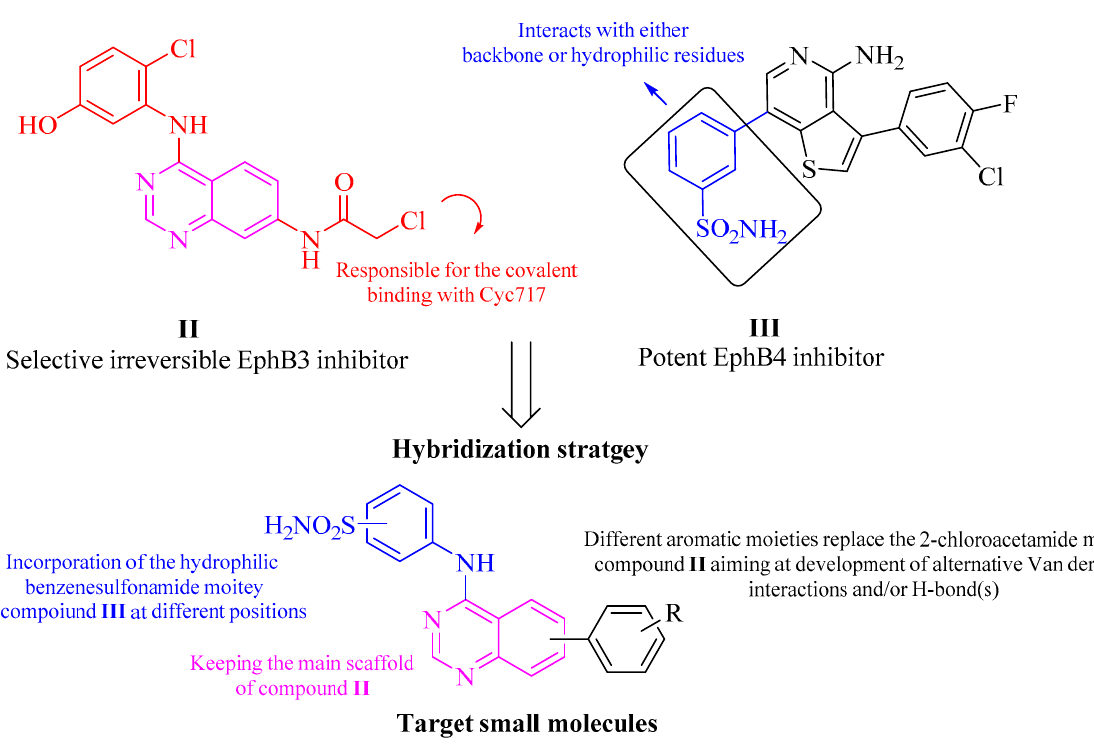
Figure 3. Design of the target small molecules via applying a structural hybridization strategy of compounds II and III .